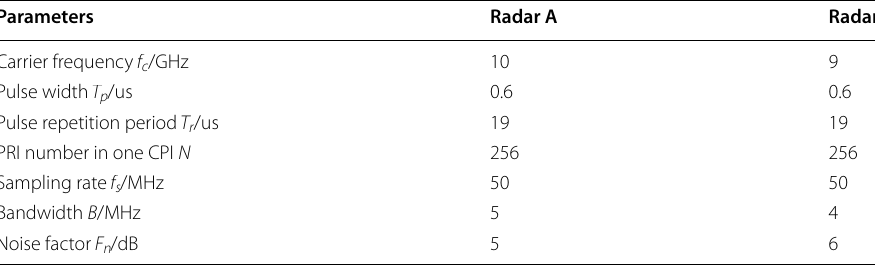
Table 1 The radar parameters Parameters Radar